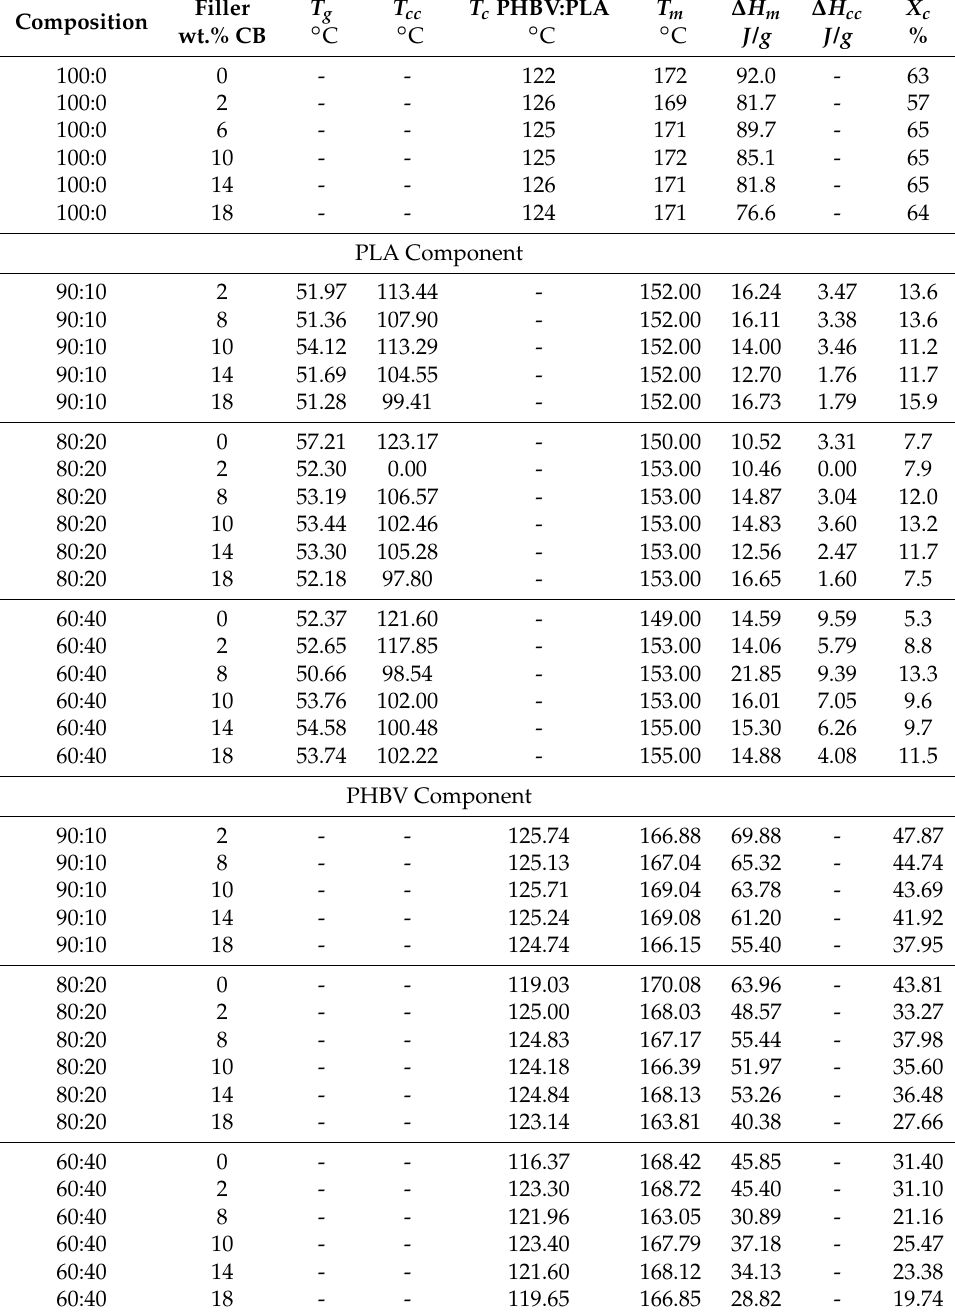
Table A1. Differential scanning calorimetry of the PHBV:PLA blended